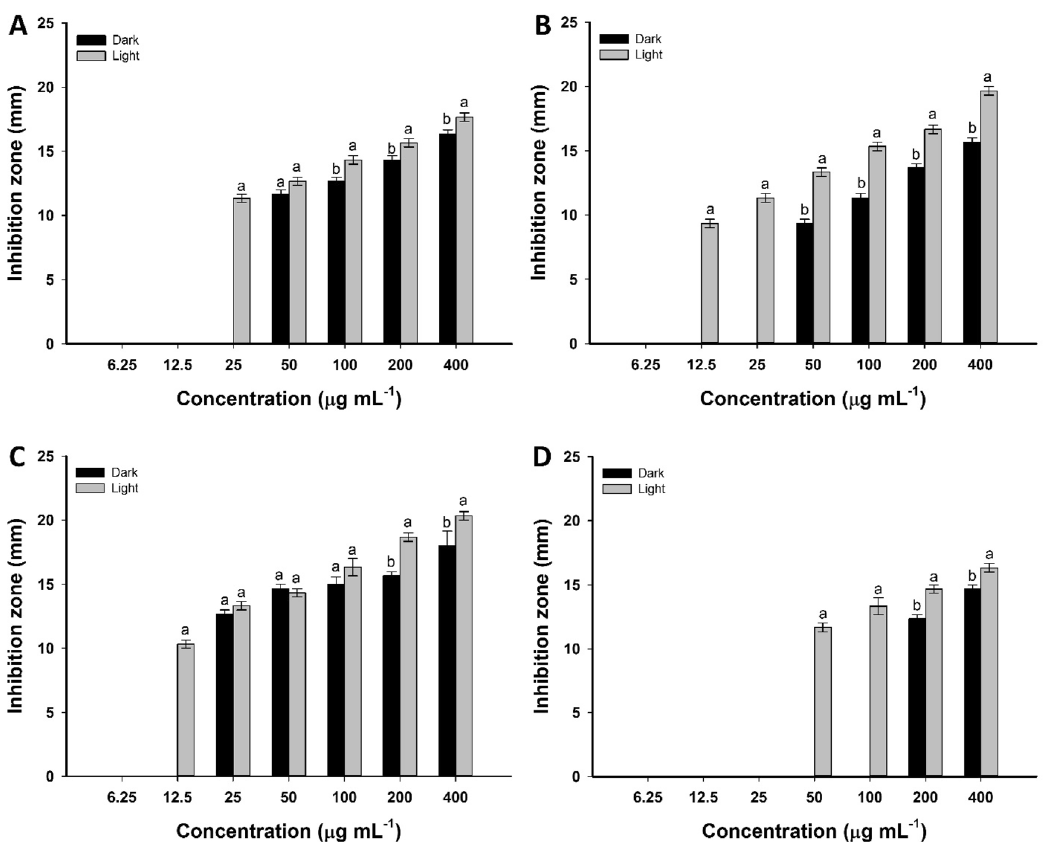
Figure 4. The activity of green synthesized Se-NPs against different strains of Candida after incubation under dark and light conditions. Candida albicans ( A ); Candida glabrata ( B ) ; Candida tropicalis ( C ) ; and Candida parapsilosis ( D ) . Data are statistically different at p ≤ 0.05 by Tukey’s test, ( n = 3); error bars are based on three independent experiments (means ± SD). Different letters at the same concentration refer to the data that are significantly